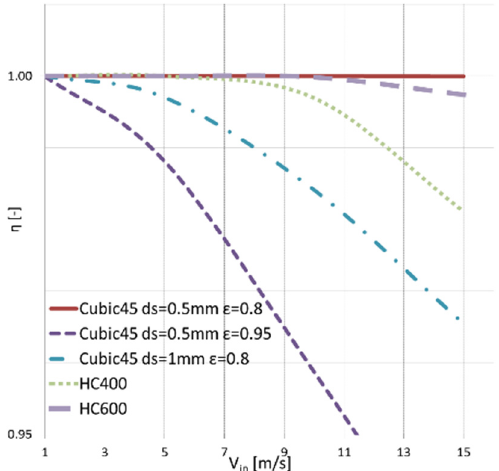
Figure 3. Conversion efficiency ( η ) vs. gas flow speed (Vin) of three additively manufactured structures based on a rotated cube elementary cell (cubic 45) for different struts diameter (ds) and porosities ( ε ) in comparison with two state-of-the-art honeycombs (HC) with different cpsi (i.e., 400 and 600). All measurements were performed at high exhaust gas temperatures and under stationary conditions. Thus, the catalyst was operating in the mass transfer limited regime. Data source [16].